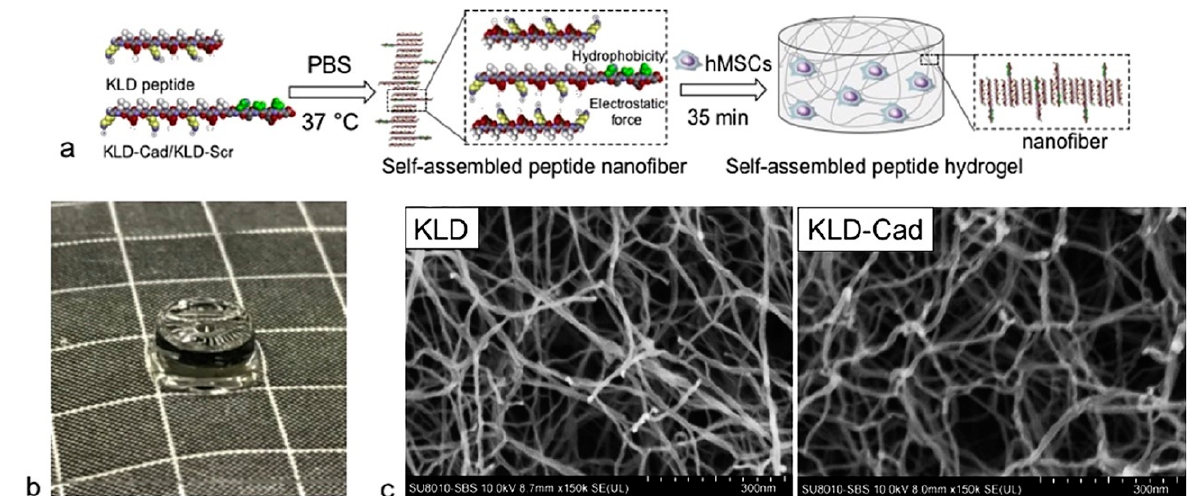
Figure 4. ( a ) Scheme of self-assembly of hMSC-encapsulated KLD-Cad/KLD-Scr hydrogels. ( b ) Photograph of KLD-Cad self-assembled hydrogel (d = 5 mm, h = 2.2 mm) ( c ) SEM images of KLD (left) and KLD-Cad (right) hydrogels after critical point drying show that the average diameter of self-assembled fiber in the KLD and KLD-Cad hydrogels are approximately 17.6 nm and 20.4 nm, respectively. Reprinted from [91], copyright © 2022, with permission from Elsevier.